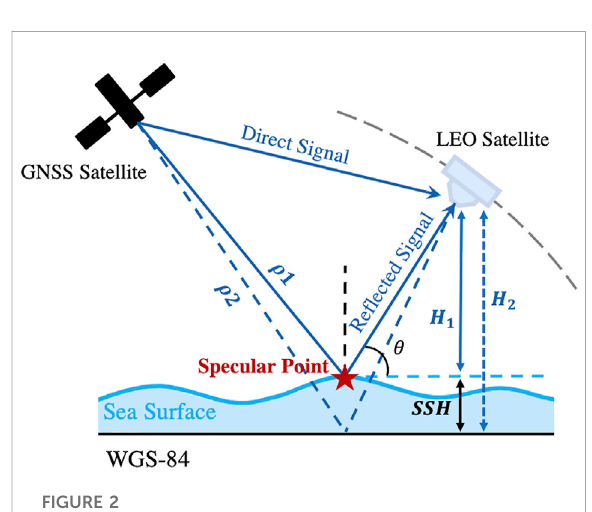
FIGURE 2 Geometry of spaceborne GNSS-R based SSH